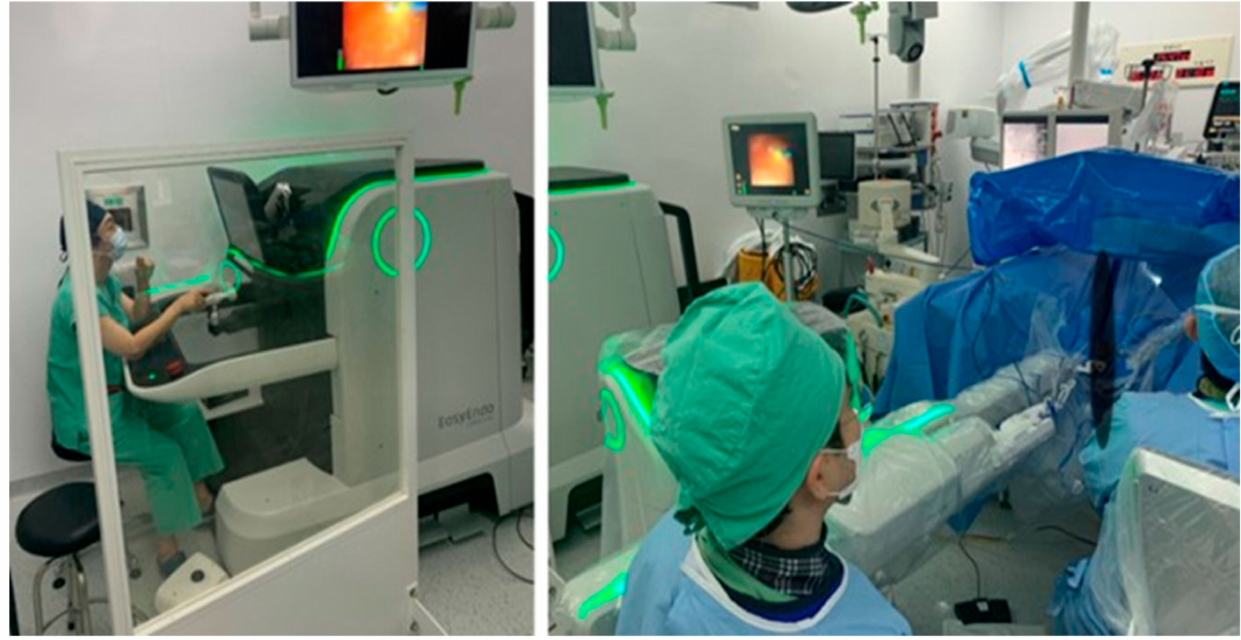
Figure 3. General view of the prototype of the EasyUretero ® robotic flexible ureteroscopic system: master’s console on the left ; the slave robot on the right